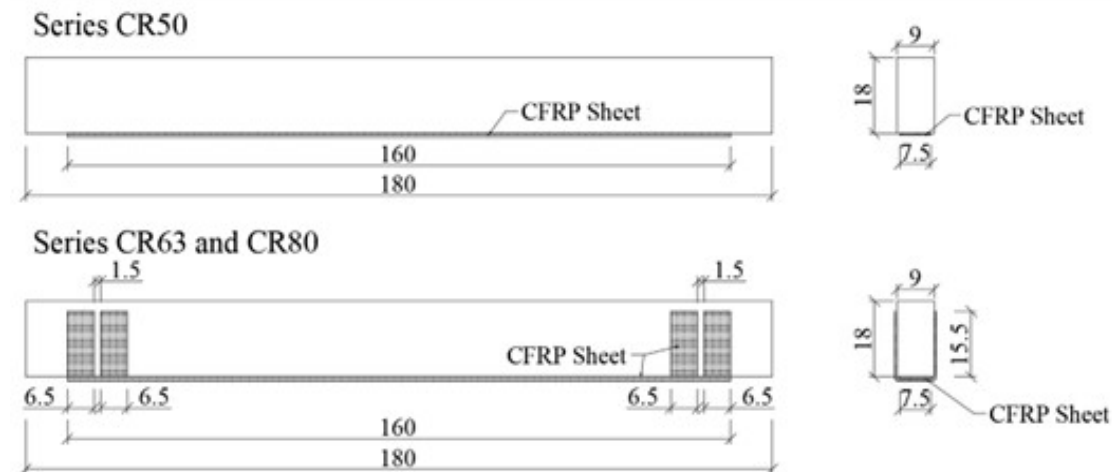
Figure 7. Schematics of beams reinforced with CFRP sheet. Dimensions in